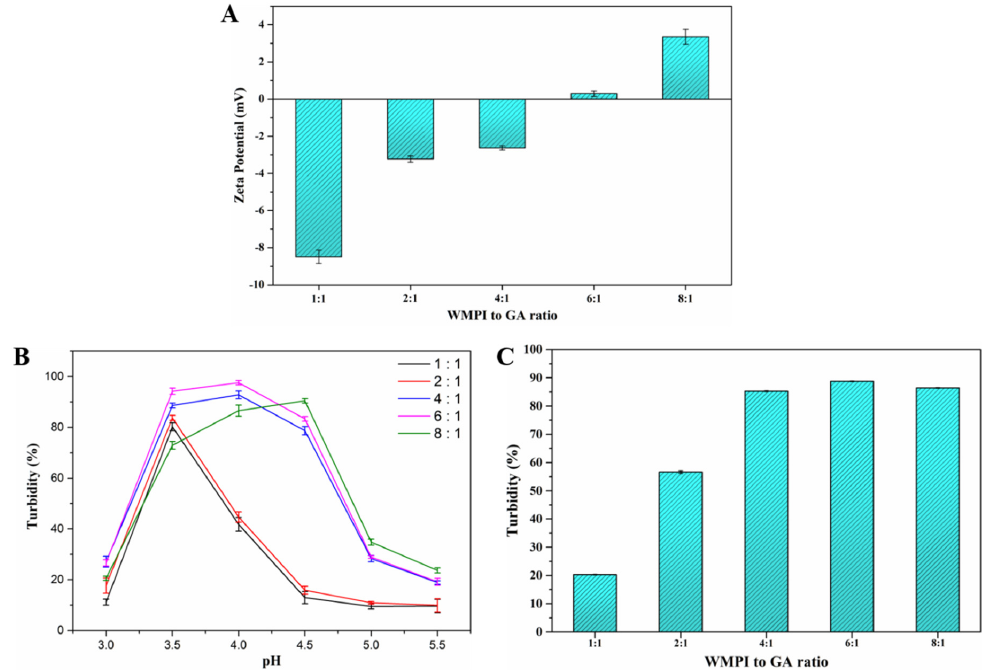
Figure 3. Effect of complex coacervation ratio of WMPI and GA at pH 4.0 on zeta potential ( A ), Turbidity of WMPI-GA systems with different mixing ratio as a function of pH ( B ) and turbidity of WMPI-GA systems with different mixing ratio at pH 4.0 ( C ).